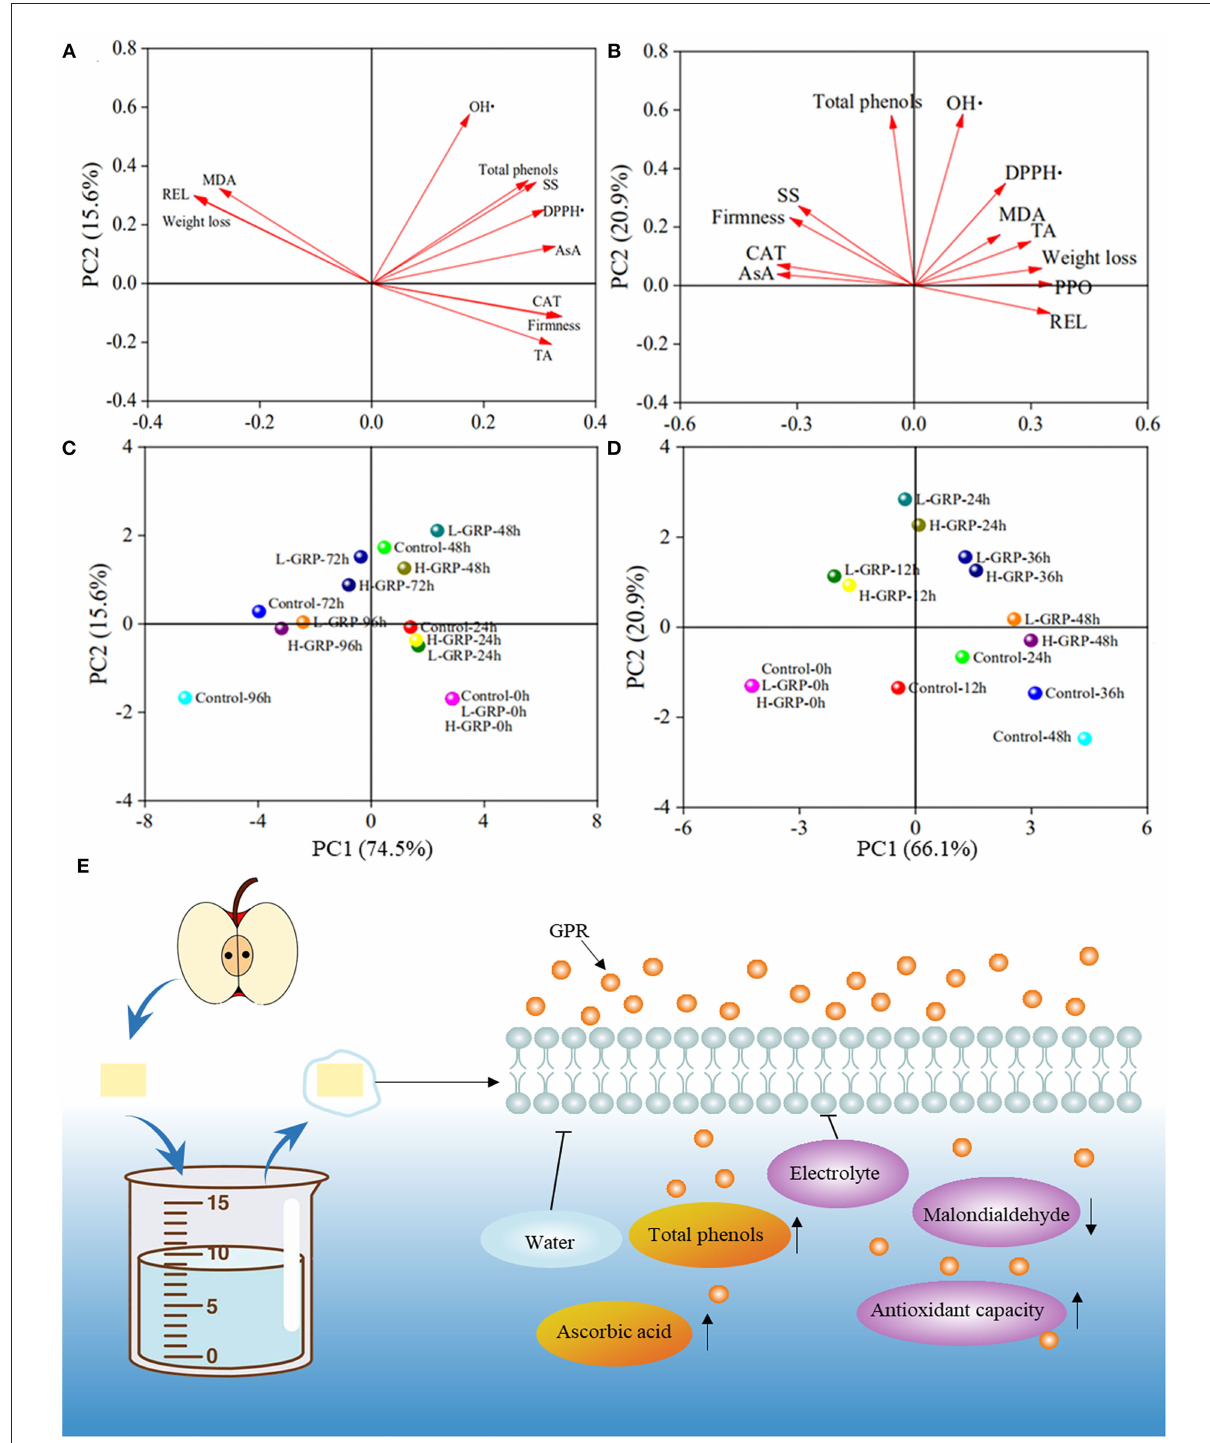
FIGURE6 Principal components analyses in loading (A,B) and score (C,D) plots of different variances in effects of GRP coating on strawberry (A,C) and fresh-cut apple (B,D) during storage, and taking fresh-cut apple as an example, possible mechanisms (E) of GPR coating for fruit preservation. The up and down arrows represent inhibition and boost, respectively. GPR, ginsenosides-extracting residue polysaccharides; AsA, ascorbic acid; CAT, catalase; DPPH • , DPPH radical scavenging activity; MDA, malondialdehyde; OH • , hydroxyl radical scavenging activity; PPO, polyphenol oxidase; REL, relative electrolyte leakage; SS, soluble solids; TA, titratable acidity; Control, fruits treated with deionized water; L-GRP and H-GRP, fruits coated with GRP at 5 and 20 mg/ml in respective. Lengths of arrows (A,B) indicate information drawn from a variance; circles of different colors (C,D) represent different treatments of strawberry and fresh-cut apple for